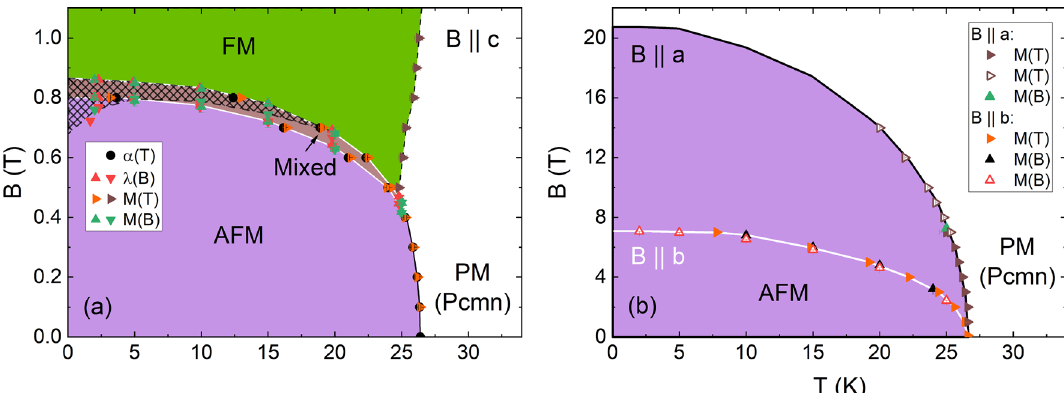
Figure 6. Magnetic Phase Diagrams: ( a ) Low-temperature magnetic phase diagram for B (cid:31) c . The hatched area displays the hysteresis region visible in isothermal magnetization and magnetostriction curves. Where hysteresis and the mixed phase overlap, white lines indicate phase boundaries obtained from up-sweep data. ( b ) Low-temperature magnetic phase diagram for B (cid:31) a (black boundary) and B (cid:31) b (white boundary) constructed from magnetization measurements. The phase boundary T N ( B (cid:31) a > 14 T) is obtained by scaling T N ( B (cid:31) b